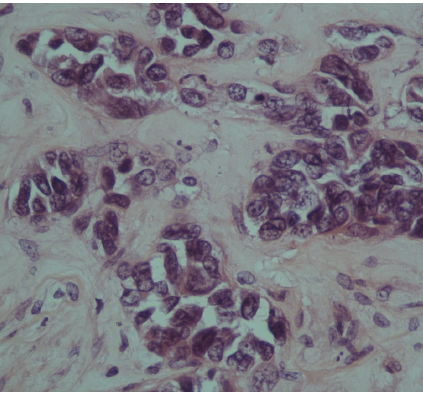
Figure 1: Photomicrograph of renal cell